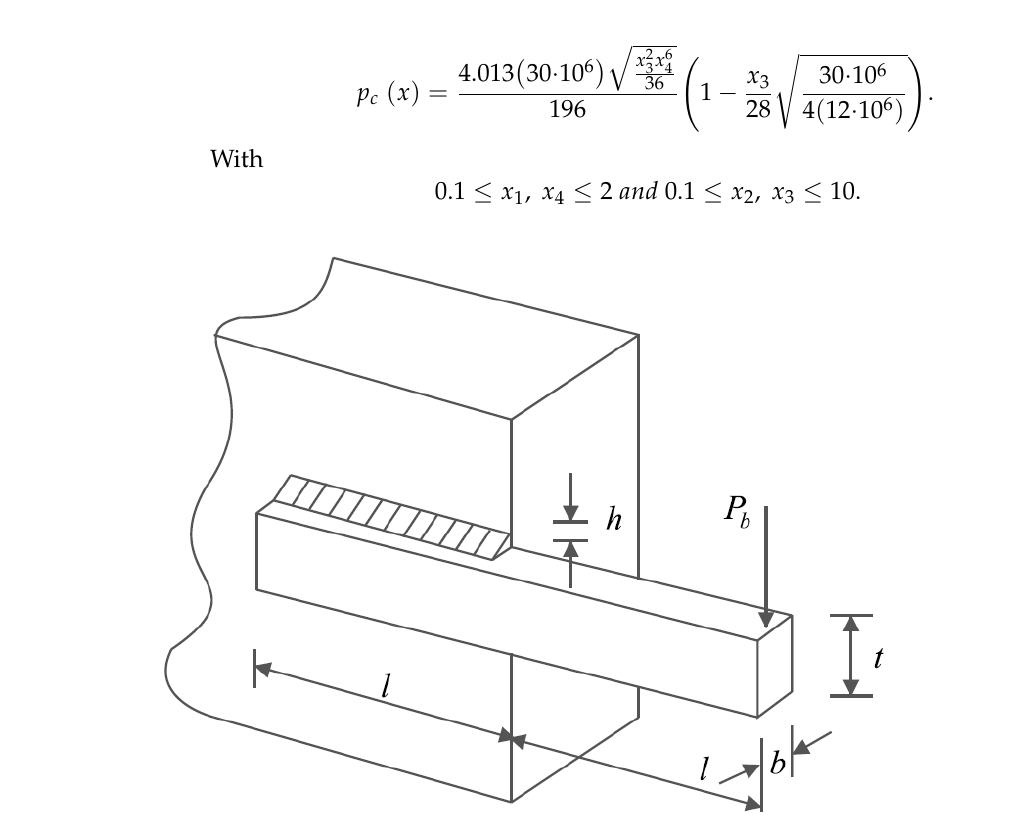
Figure 9. Schematic of welded beam design.